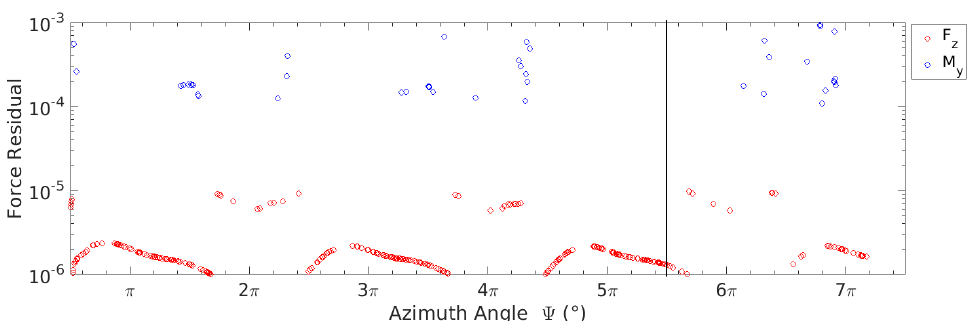
Figure 2. Force residual as a function of simulation time history expressed in azimuth